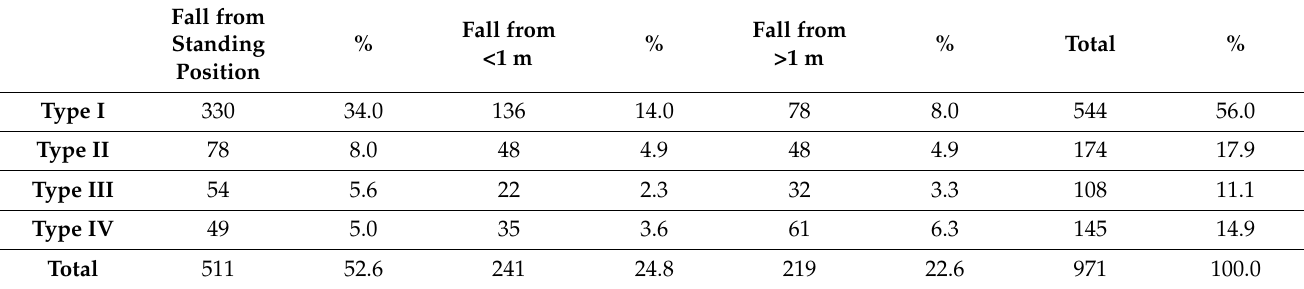
Table 5. Fracture classification according to fall height.